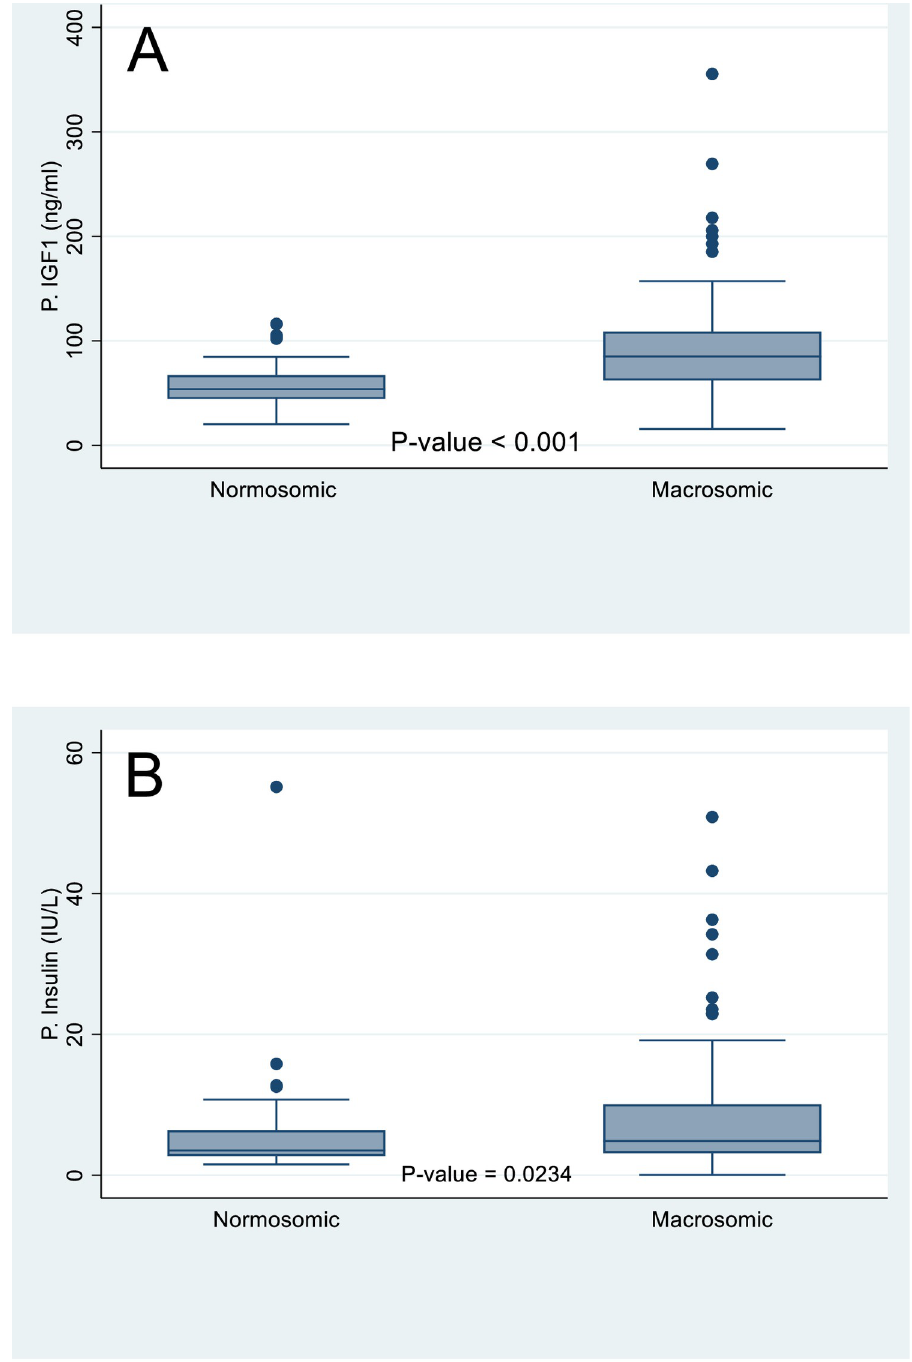
Fig 1. A. Distribution of GF-1(ng/ml) among macrosomic and normosomic babies. B. Distribution of Insulin (IU/L) among macrosomic and normosomic babies. After multivariable analysis that corrected for confounding factors, maternal BMI at birth (P-value < 0.001), fetal gender (P-value = 0.001), fetal cord serum IGF -1 (P-value = 0.002), and insulin assay (P-value = 0.034) were significantly associated with fetal macrosomia. Also,